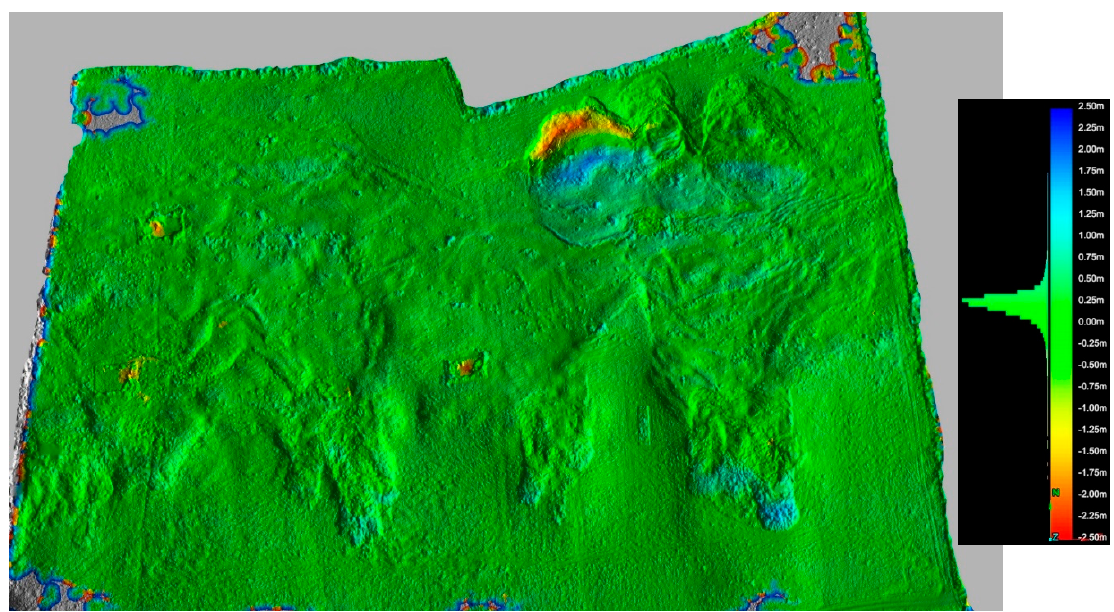
Figure 16. Hollin Hill landslide Change model (2008 – 2018). Red -2.5m, Blue +2.5m.